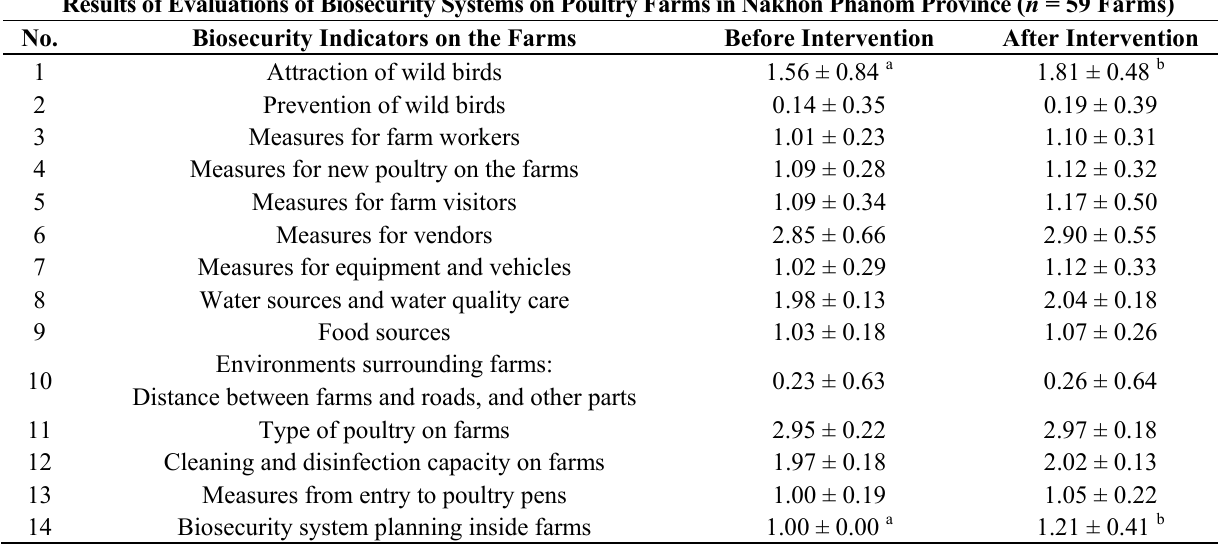
Table 1. Comparison of the biosecurity system on layer farms in poultry production clusters (PPCs) in Nakhon Phanom province before and after